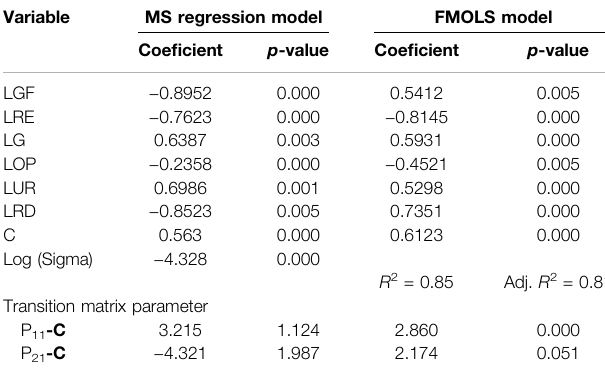
TABLE 6 | Outcomes of FMOLS amd MS